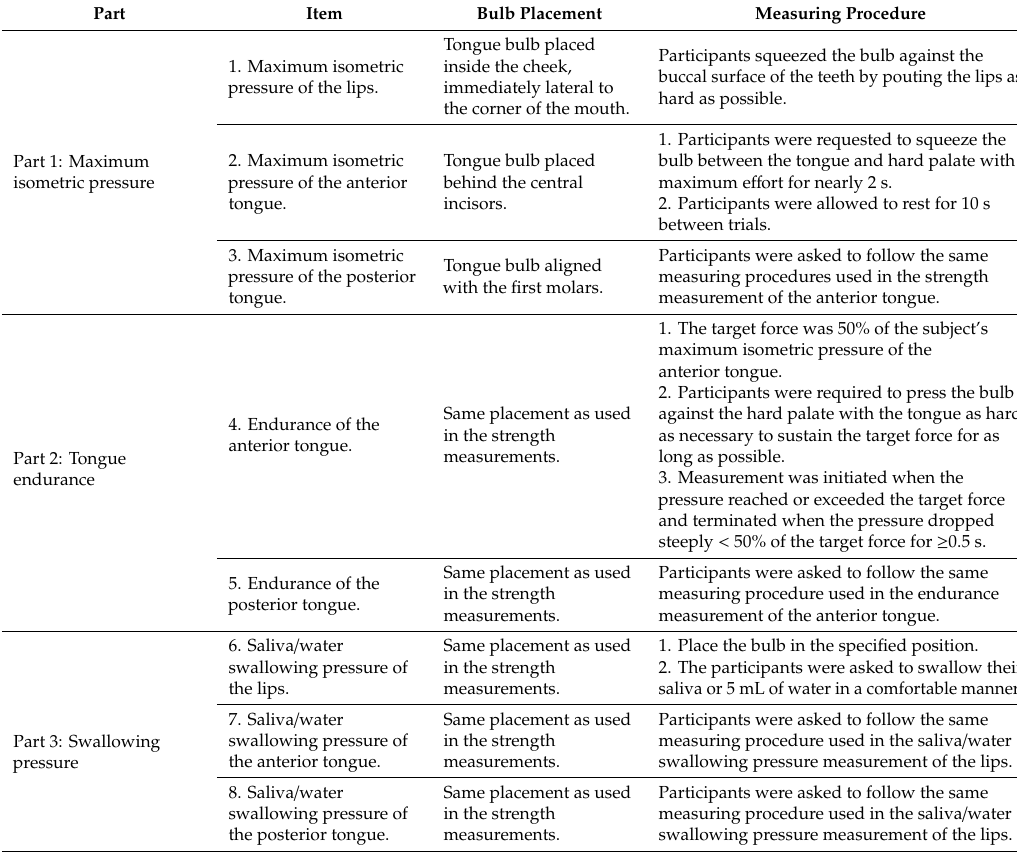
Table 1. Measuring procedures for the maximum isometric pressure, tongue endurance, and swallowing